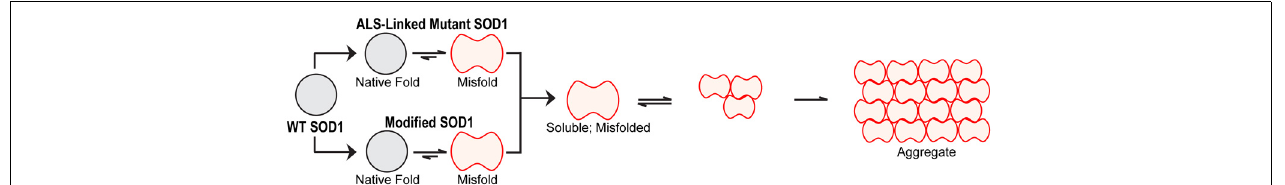
FIGURE 3 | Misfolded vs. aggregated SOD1. Misfolded SOD1 results from both ALS-linked mutations and aberrant post-translational modifications. Throughout the review, the term “misfolding” refers to the structural loosening of SOD1 due to a mutation and/or altered post-translational modification within a soluble form of the protein. Misfolded, soluble SOD1